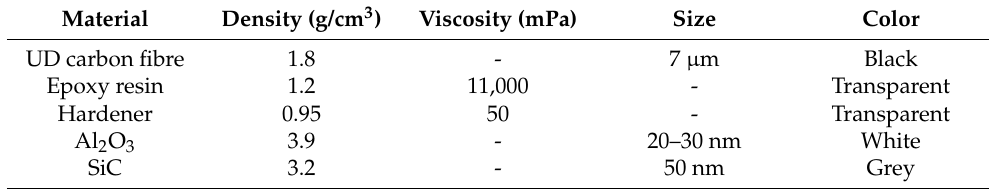
Table 1. Properties of materials used for fabrication of CFRP and hybrid nano-composites.